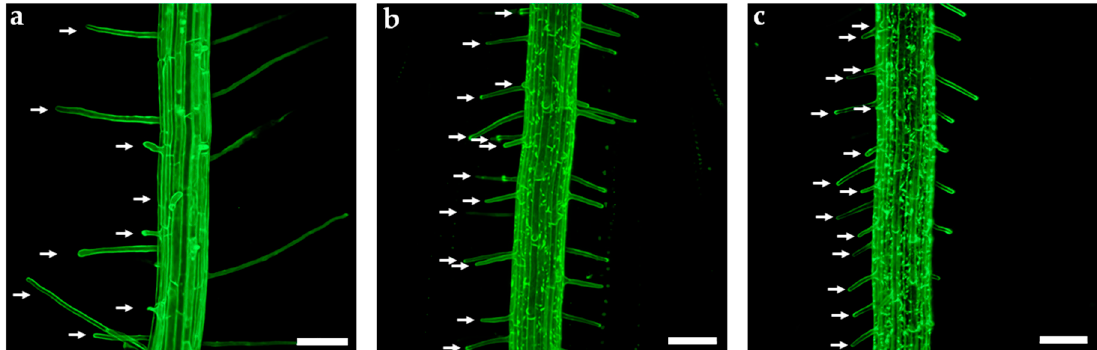
Figure 5. PAW regulates the number of root hairs and epidermal cell size in the Arabidopsis root ( WER::GFP / cobl9-1 ). Arabidopsis seedlings were grown in solid media for 7 days. ( a ) DW, ( b ) PAW5, ( c ) PAW19. The white arrows indicate the individual root hairs that were used in the quantification. Bar = 100 μ m.